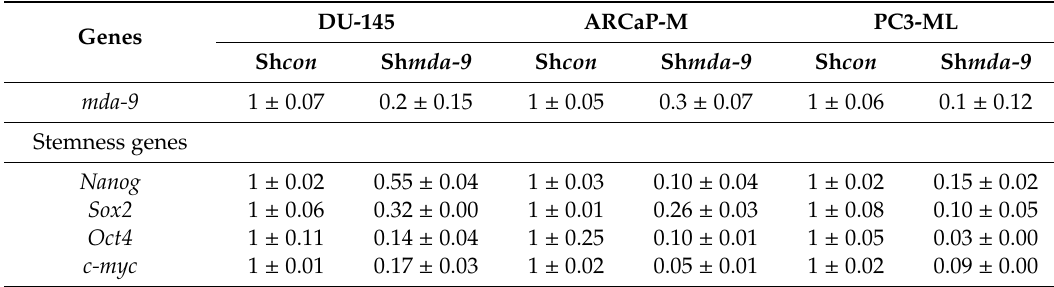
Table 3. E ff ect of knockdown of mda-9 (sh mda-9 ) on the expression of stemness genes in prostate cancer cell lines.